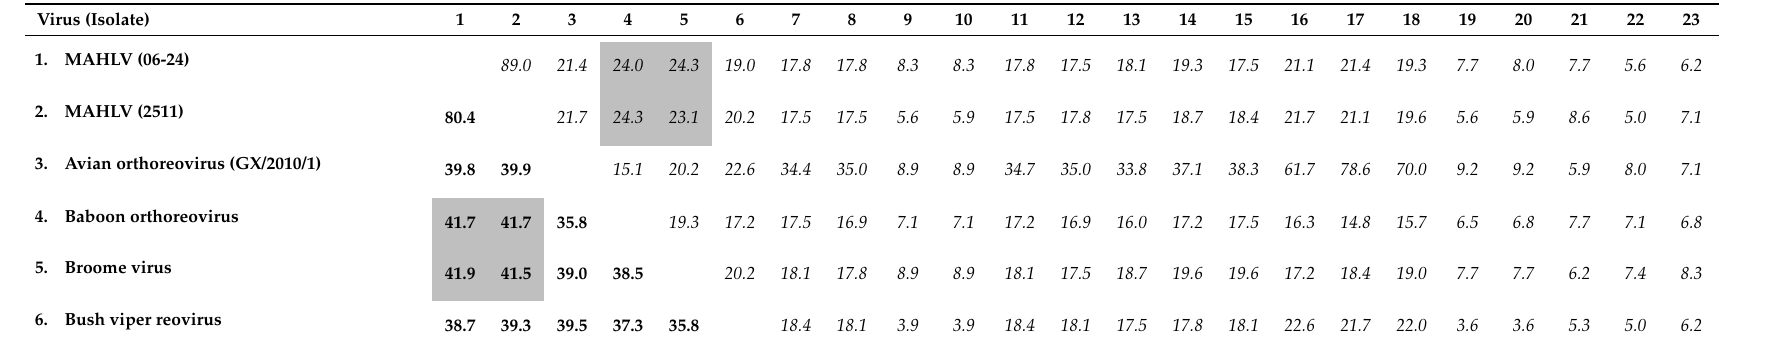
Table 3. Identity values (%) of the Sigma B encoding segments and deduced amino acid sequences of MAHLV and other orthoreoviruses. Nucleic acid sequences are in the bottom left triangle and in bold text, and deduced amino acid sequences are in the top right triangle in italics. The grey shaded areas indicate the identity values of the closest related virus(es) to